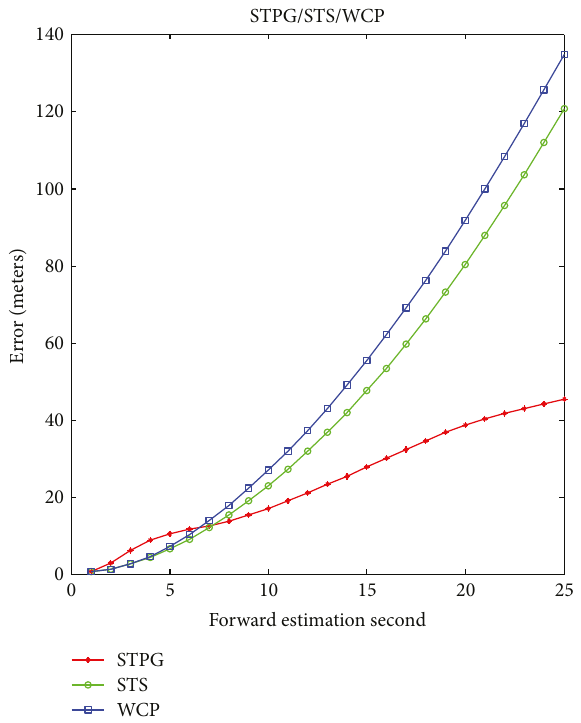
Figure 14: STS versus WCP versus STPG prediction